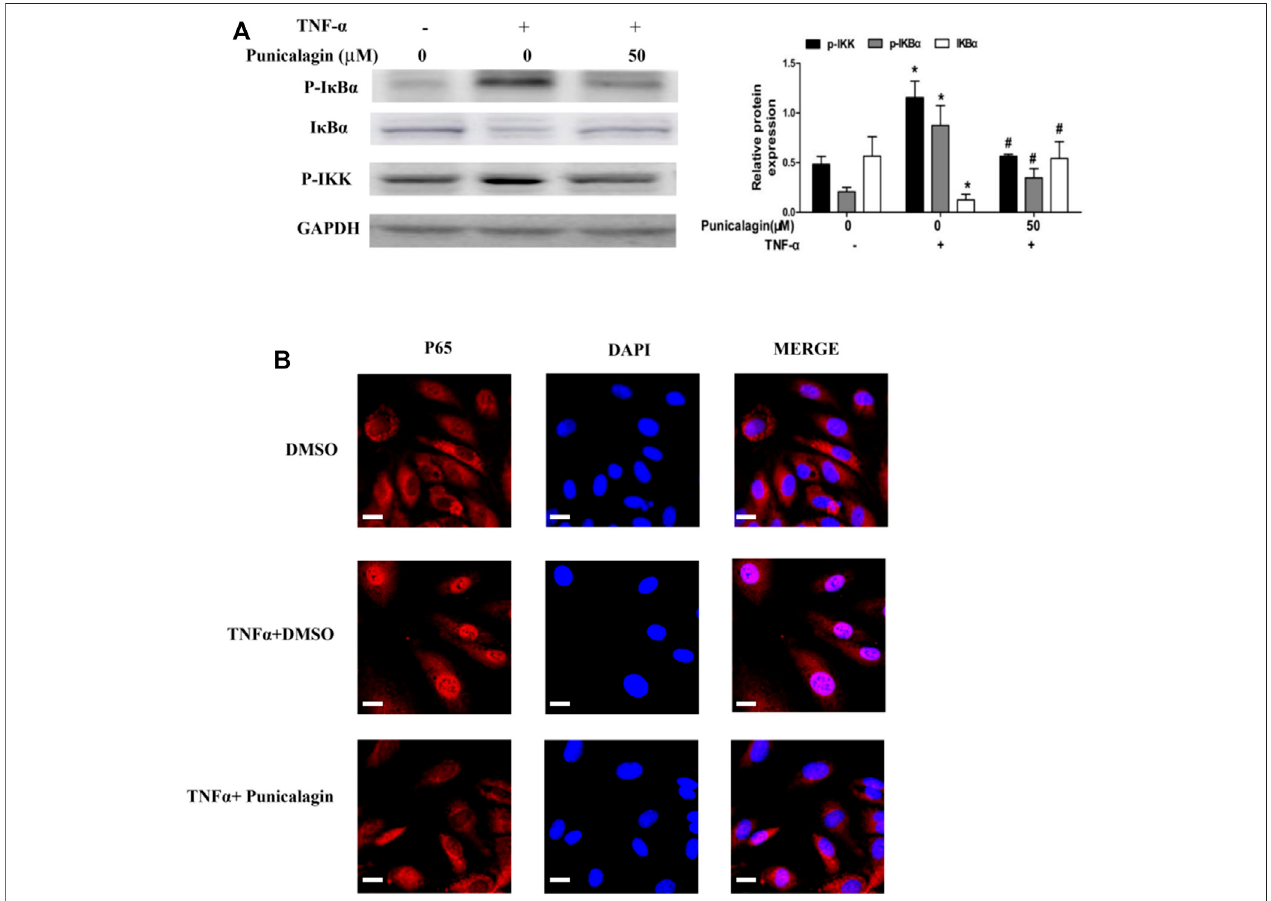
FIGURE9| RegulatoryeffectofpunicalaginonNF- κ Bsignaling pathway ofHUVECs. (A) Difference intheexpression ofphosphorylatedI κ B α ,phosphorylatedIKK and I κ B α with DMSO (control) and punicalagin (50 µM). (B) Position of p65 in cells tracked by immuno fl uorescence staining. Data are represented as mean ± SD. * p < 0.05, vs. HUVECs without TNF- α , # p < 0.05 vs. groups treatment with TNF- α alone.